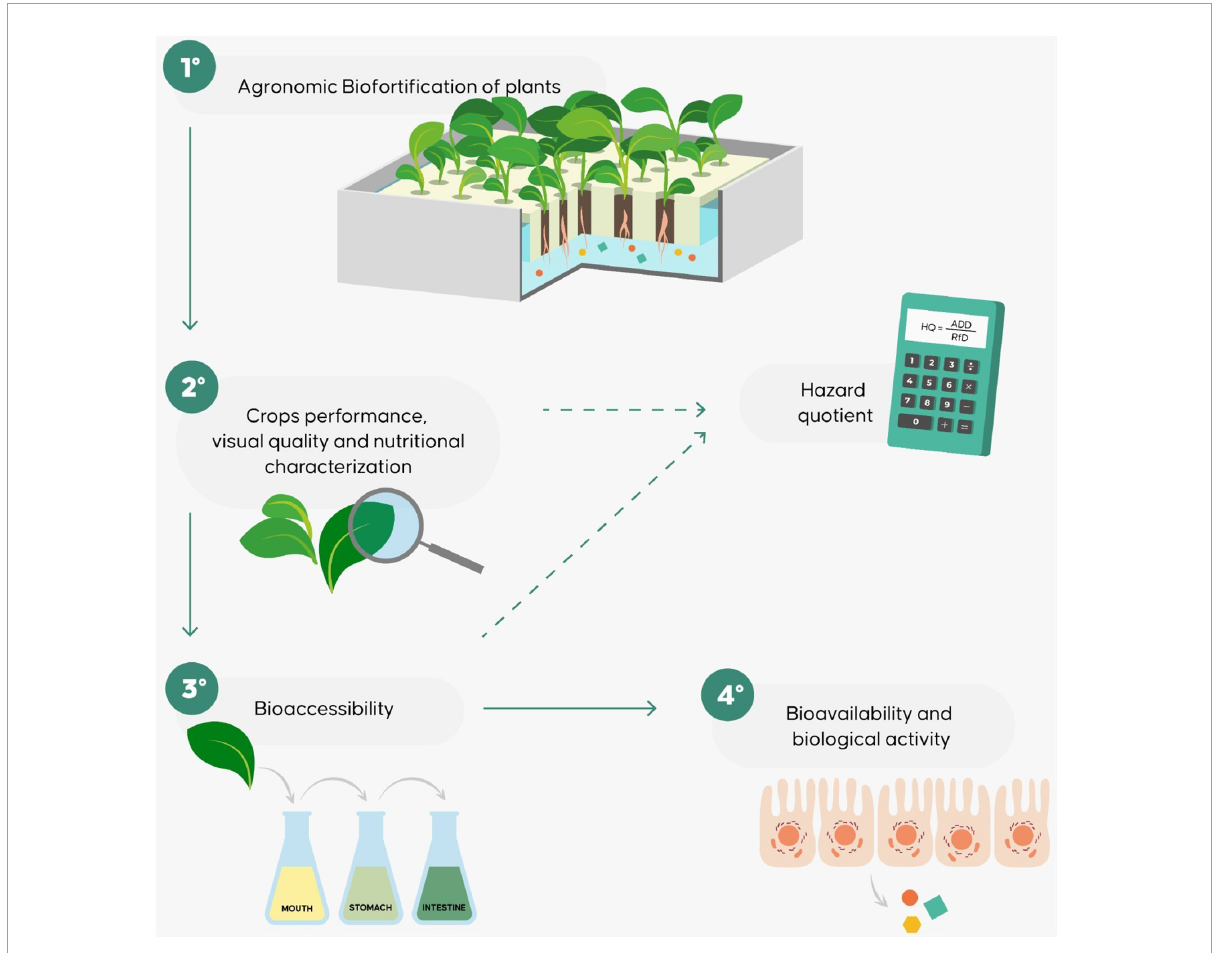
FIGURE4 The workflow proposed to evaluate the agronomic, nutritional, and bioefficiency of biofortified